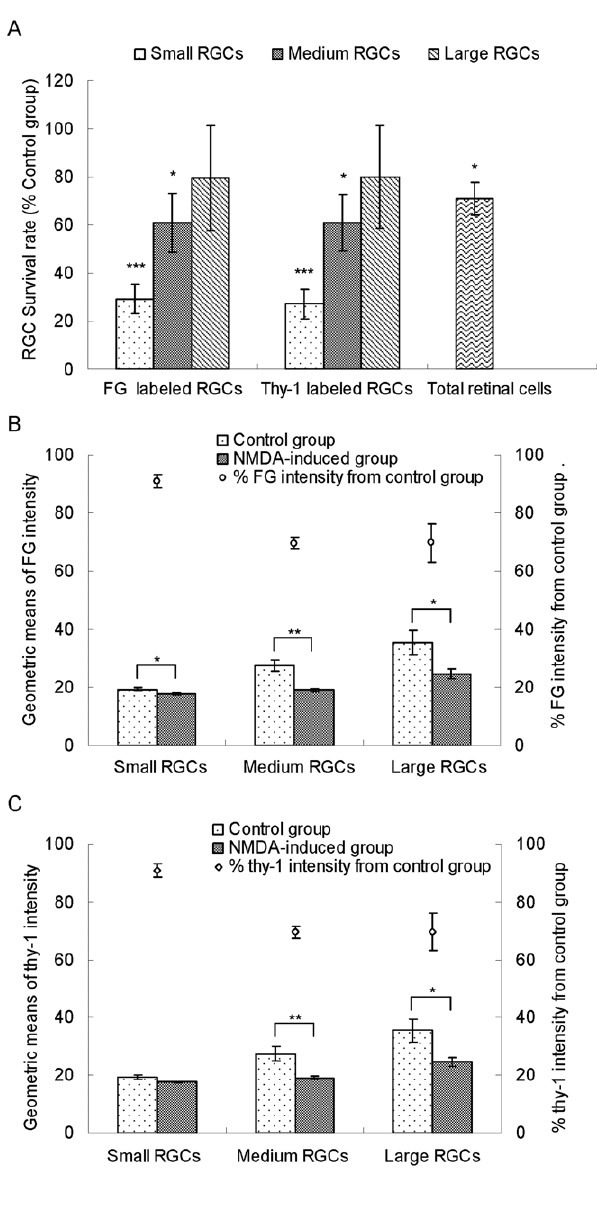
Figure 7. Quantitative flow cytometric analysis of FG and thy-1 labeled RGCs. (A) Effect of NMDA on survival rates of different size RGCs and total RGCs compared to the control group (n=6). Total RGCs were counted using a hemacytometer and the percentages of different size RGCs in total retinal cells were determined by flow cytometry. The numbers of different size RGCs were calculated according to the above results. (B) Quantitative analysis of FG intensities of different size RGCs following intravitreal NMDA injection (n=6). (C) Quantitative analysis of thy-1 intensities of different size RGCs following intravitreal NMDA injection (n=6). FG and thy-1 intensities were expressed as geometric means calculated by CellQuest Pro software. Data were presented as mean 6 standard error of the mean. Differences between the control and NMDA groups were analyzed using the Student’s t -test. *P , 0.05, **P , 0.01 and ***P ,